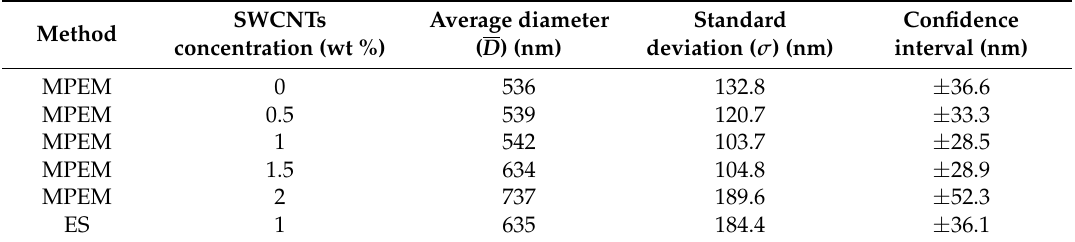
Figure 2. Scanning electron microscopy (SEM) pictures of single-walled carbon nanotubes/ polyacrylonitrile (SWCNTs/PAN) composite nanofibers with different SWCNT concentrations. The right most figures are the according diameter distribution. ES: electrospinning. Table 1. The relationship between the content of the SWCNTs and the average diameters of composite nanofibers.